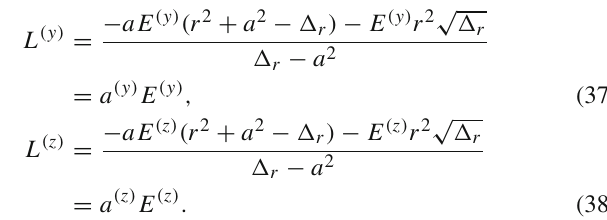
momentum leads to decrease in the negative energy and for the small values of angular momentum, it takes higher val- ues. The left and right graphs in the lower panel are depicted for different values of α as well as Q , respectively. It is observed that negative energy shows decreasing behavior as α increases and it takes higher values for increasing values of α . In the Penrose process, the produced particle has more negative energy in the presence of DE as compared to its absence. The right graph represents that the produced parti- cles may have less negative energy for large values of Q